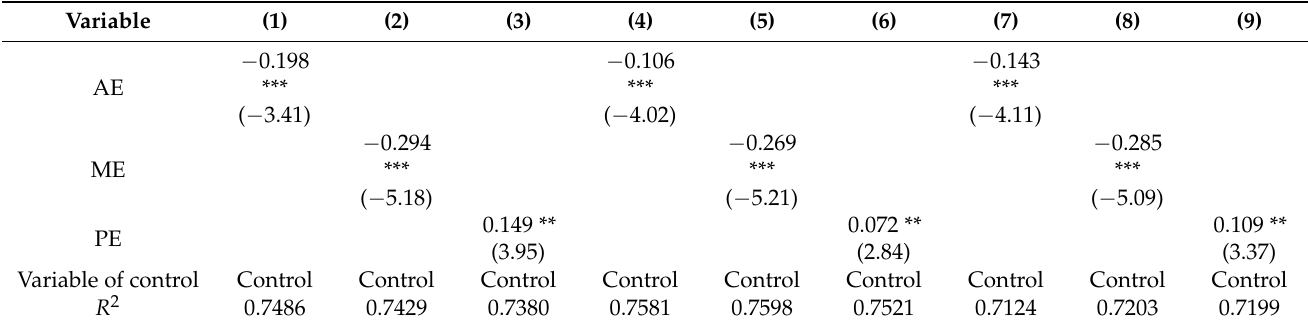
Table 3. Robustness